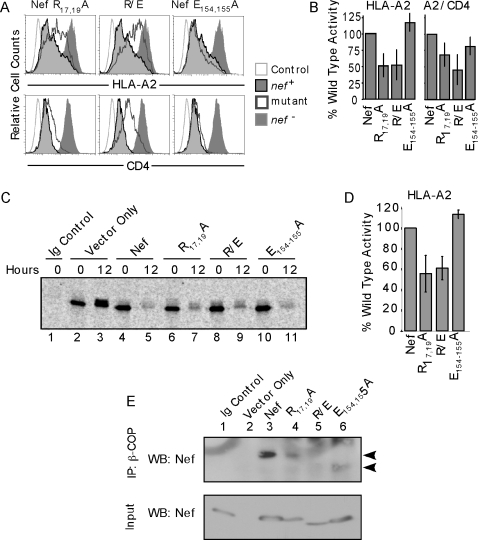
Two Nef domains recruit β-COP, but only one is used for the
degradation of HLA-A2.(A) Flow cytometric analysis of HLA-A2 and CD4 expression in cells
expressing Nef mutants. CEM T cells stably expressing HLA-A2 were
spin-transduced with murine retroviral supernatants that express the
indicated Nef construct and a GFP cassette from an internal ribosomal
entry site. The cells were gated for GFP expression and results of
HLA-A2 (top panel) or endogenous CD4 (bottom panel) staining are shown.
R/E stands for R17,19A/E154,155A double mutant.
Open light gray curve, parental cell line; shaded dark gray curve, empty
vector; black shaded curve, wild type Nef; and open dark gray curve, Nef
mutant. (B) Quantification of down-modulation. The mean±SD
for greater than or equal to six experiments (actual number varies
depending on the mutant) is shown. (C,D) R17/19 is needed for
optimal HLA-A2 degradation, whereas the E154/155 is
dispensable. CEM T cells expressing HLA-A2 and Nef were generated as
described in part A. The cells were pulse labeled with
35S-labeled amino acids, chased for 0 or 12 hours in complete
medium and lysed. HLA-A2 was immunoprecipitated with the anti-HLA-A2
antibody BB7.2, separated by SDS-PAGE and quantified using a
phosphorimager. “Ig Control” indicates results from
HLA-A2-negative parental CEM cells immunoprecipitated with BB7.2
antibody. (D) Quantification of degradation. Nef activity was calculated
as follows: (the fraction of HLA-A2 remaining in control cells /the
fraction of HLA-A2 remaining in Nef expressing cells). The value
obtained for each mutant was divided by that for wild type Nef and
multiplied by 100 to calculate % wild type activity. The
mean±SD for two experiments is shown. (E) R17/19
and E154/155 are required for the β-COP/Nef
interaction. CEM T cells expressing HA-A2 were transduced with a
retroviral vector expressing either wild-type Nef or the indicated Nef
mutant. The cells were immunoprecipitated with an
anti–β-COP antibody and the presence of Nef was
assessed by western blot as described in Materials and Methods. The Ig control is
HLA-A2–negative parental CEM cells expressing wild-type Nef
immunoprecipitated with a control antibody (BB7.2) and the vector only
control is CEM cells expressing HLA-A2 transduced with the empty
retroviral vector.